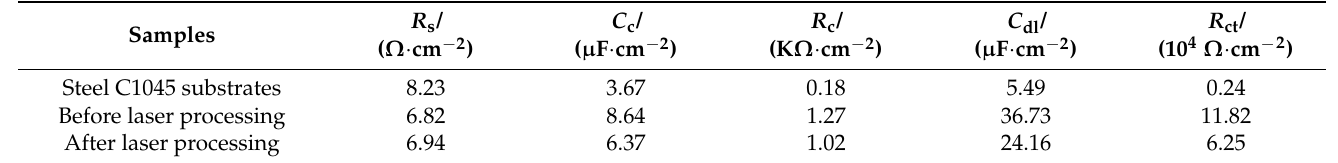
Table 7. Analyzing results of potentiodynamic polarization curves of